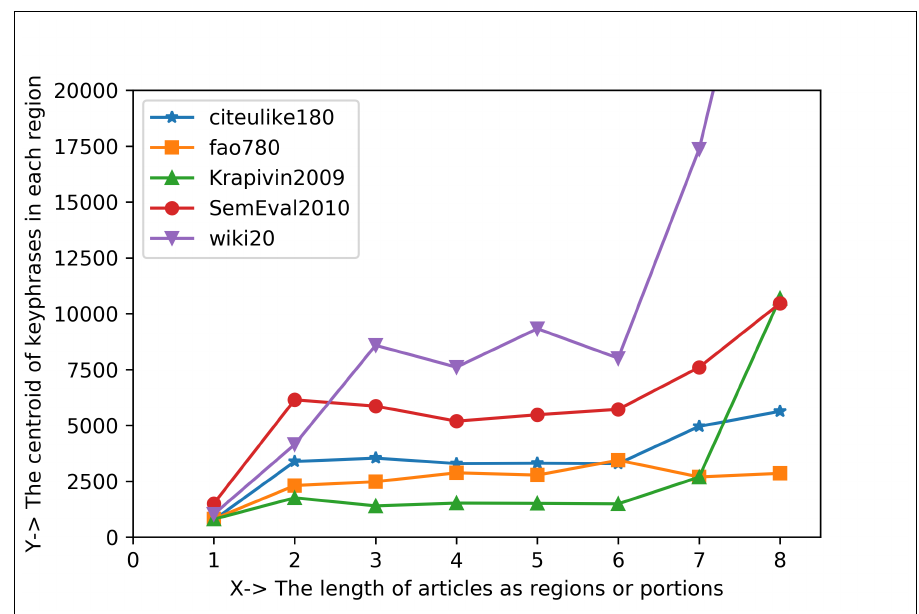
Figure 5. The analysis of keyphrase centroid using first occurrence keyphrase based on eight regions for 1st five datasets.